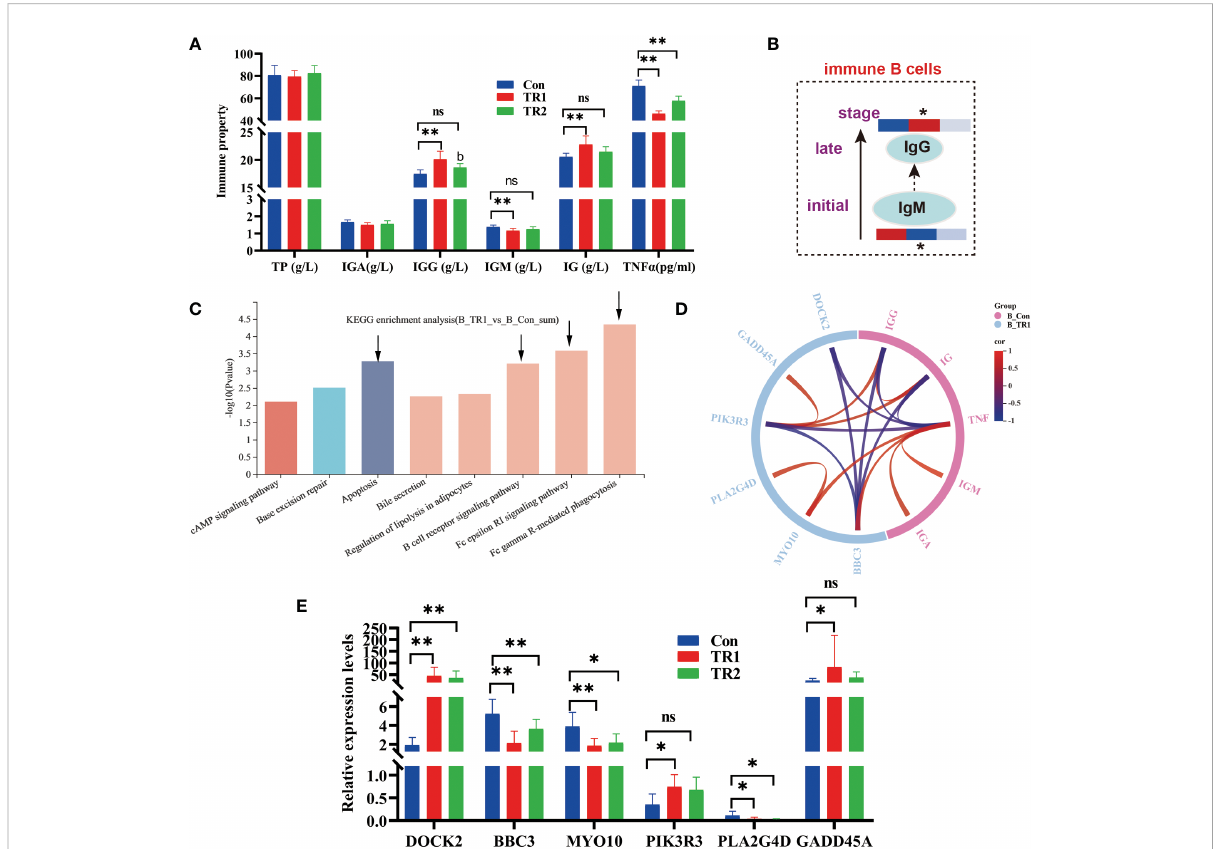
FIGURE 5 Indexes of immune properties and DEGs related to immune response. Immune indexes of serum (A) a transition from IgM to IgG in immune B cells over the course of immune response (Heat maps show the relative amounts of substances in group Con, TR1 and TR2 from left to right; * represent p <0.05, indicative of the signi fi cant difference by comparing TR1 or TR2 to Con) (B) , kegg enrichment analysis of all DEGs from TR1 vs. Con (C) , Circular correlation analysis of six selective DEGs from top 4 kegg pathway and immune indexes of serum (D) , Relative expression levels of six selective DEGs related to immune response (E) (* represents p <0.05, ** represents p <0.01, ns represents no differences in